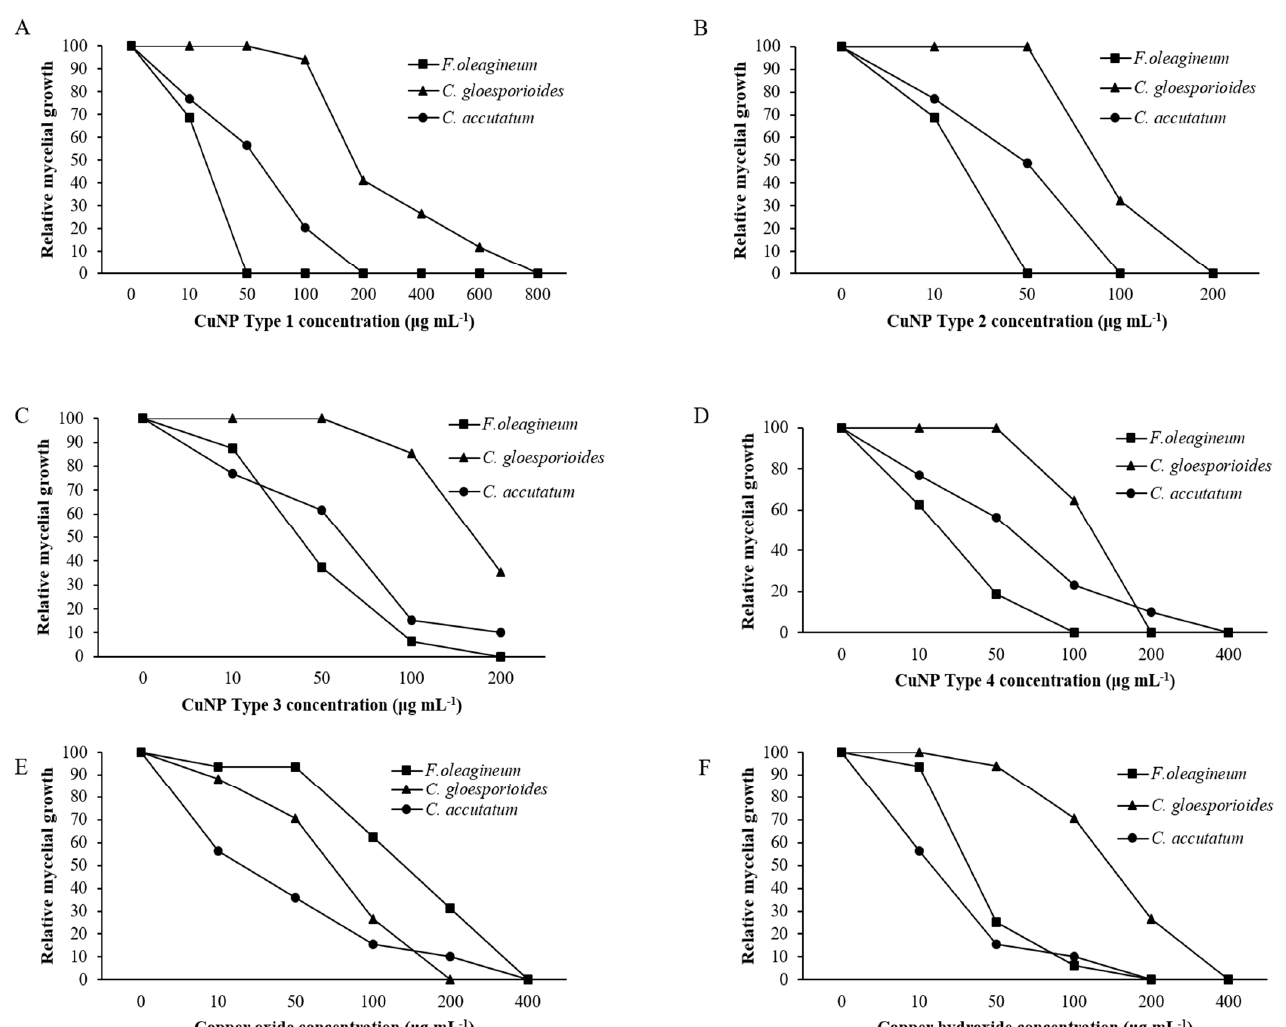
Figure 5. Mean relative mycelial growth of Fusicladium oleagineum , Colletotrichum acutatum s.s. , and Colletotrichum gloesporioides s.s. isolates on artificial nutrient media amended with several concentrations of CuNP Type 1 ( A ), CuNP Type 2 ( B ), CuNP Type 3 ( C ), CuNP Type 4 ( D ), Copper oxide ( E ), and Copper hydroxide ( F ).